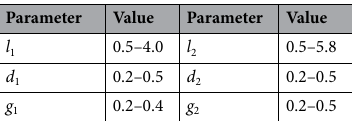
Table 1. Geometry parameter variations of the proposed anisotropic cell (unit: mm).